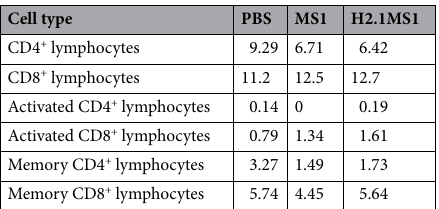
Table 2. Percentages of lymphocyte subtypes isolated from the spleens after PBS, MS1 or H2.1MS1 sphere administration.